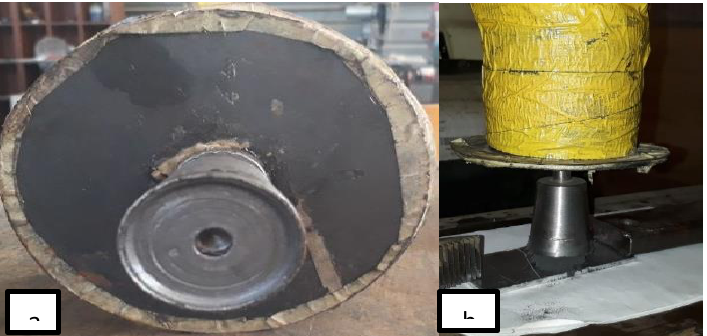
Fig. 5. Magnetic iron poles, a. Pole before applying a magnetic field, and b. Pole with the created magnetic brush.